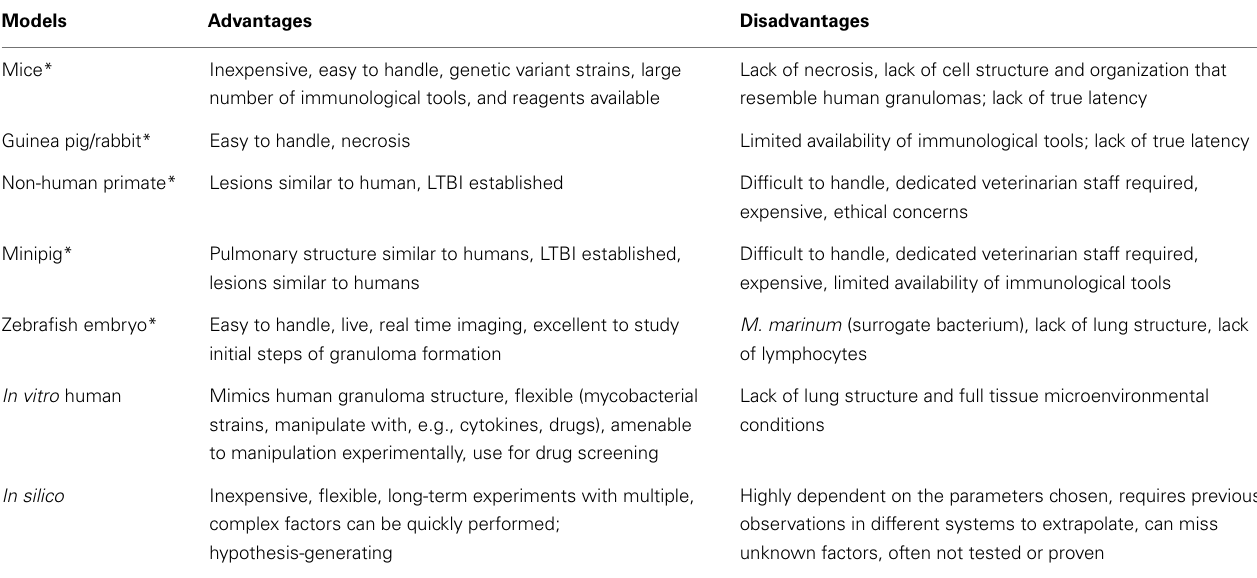
Table 1 | Models to study M.tb